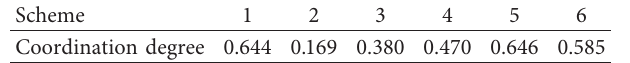
Table 7: Coordination degree of six schemes. Scheme 1 2 3 4 5